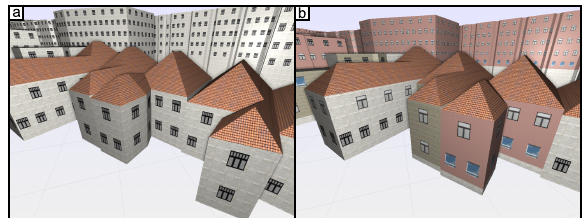
Figure 13: This image shows simple facade grammars containing only subdivisions (a) or subdivisions with randomization